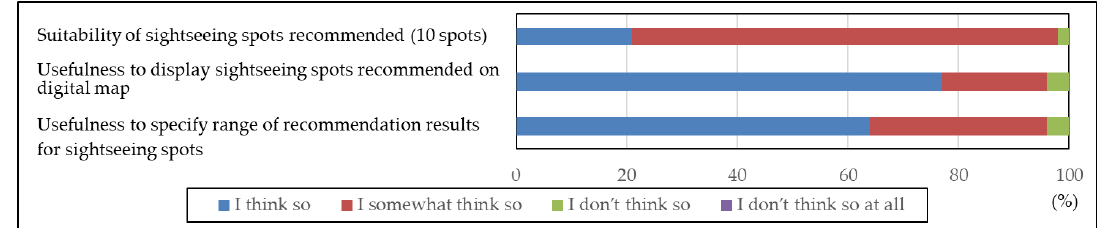
Figure 8. Evaluations concerning the overall recommendation function of sightseeing spots.